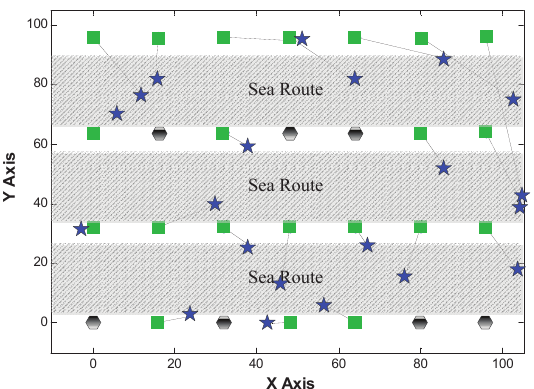
Figure 7. Localization results of multi-dimensional scaling (MDS)-Hop.